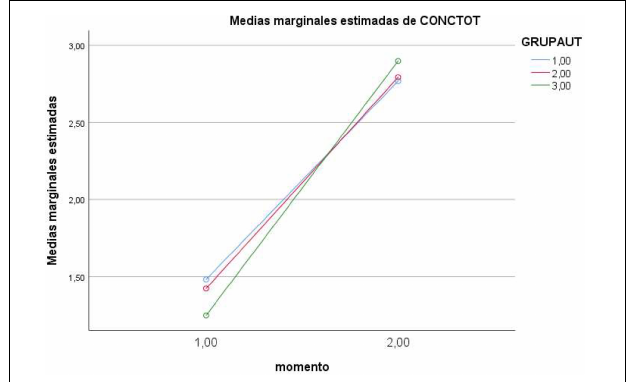
FIGURE 1 | Effects of Moment × Level of regulation on knowledge (1 = low; 2 = medium; 3 = high).